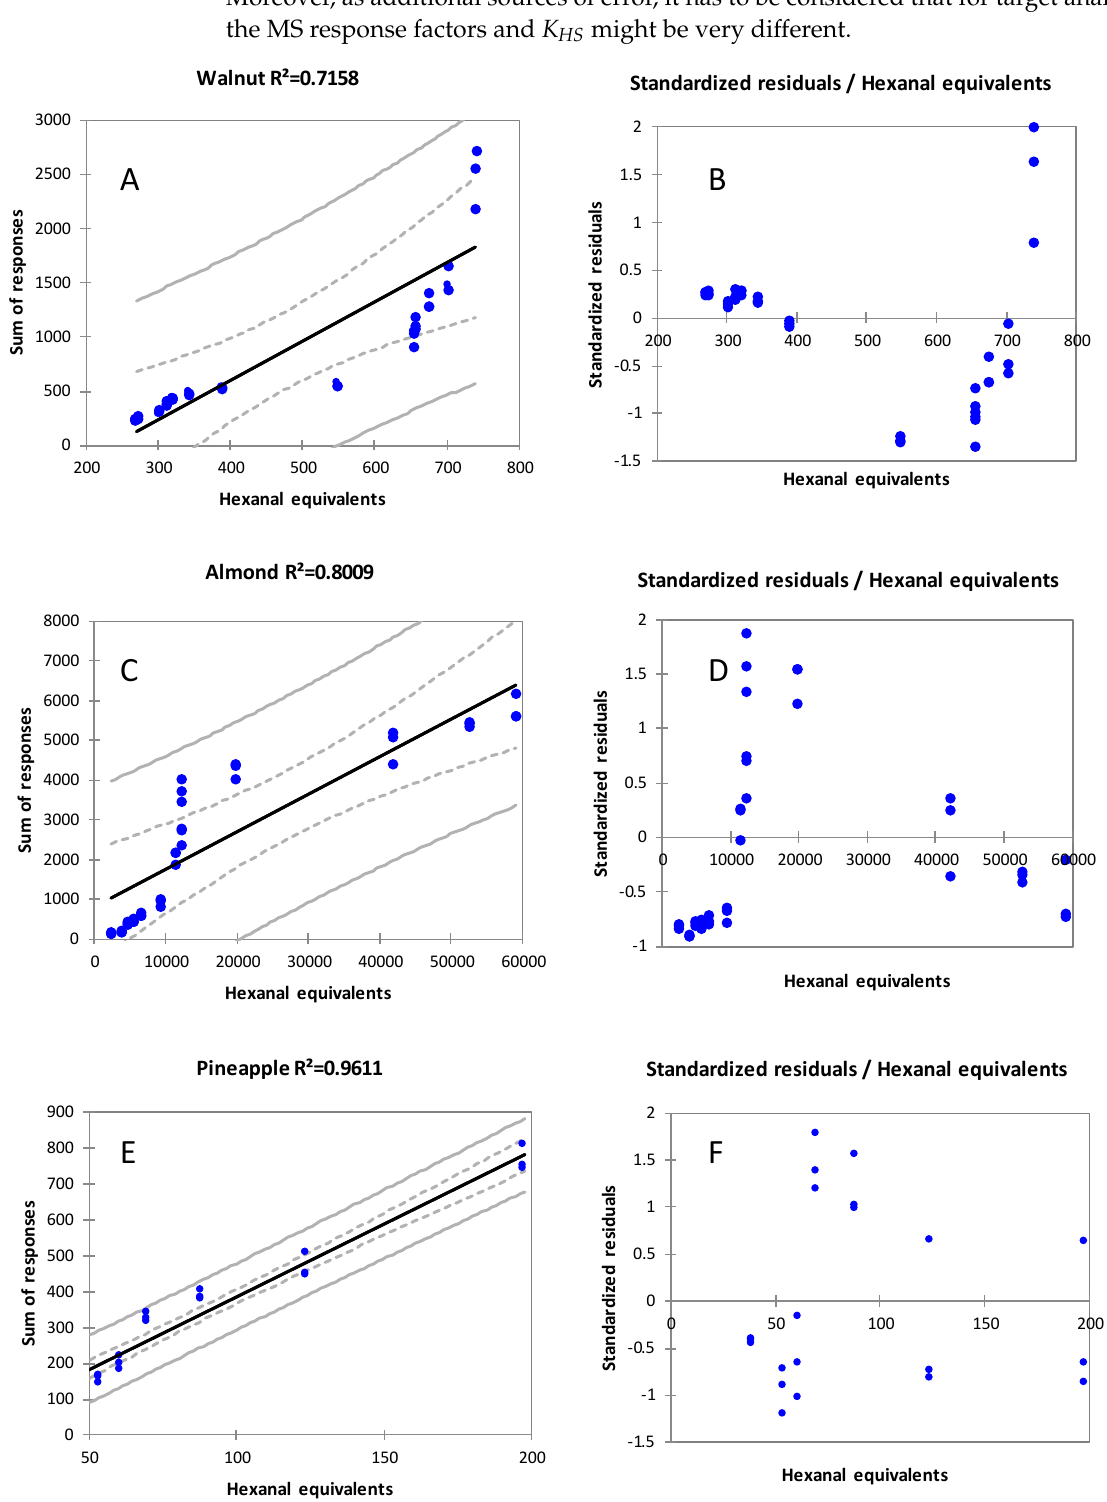
Figure 8. Linear regression analysis on normalized response data (variable y ) vs. the accurate amount of rancidity markers expressed as hexanal equivalents ng/g (variable x ). Coefficient of determination ( R 2 ) and standardized residuals are reported to complete the quality evaluation of re- sults.